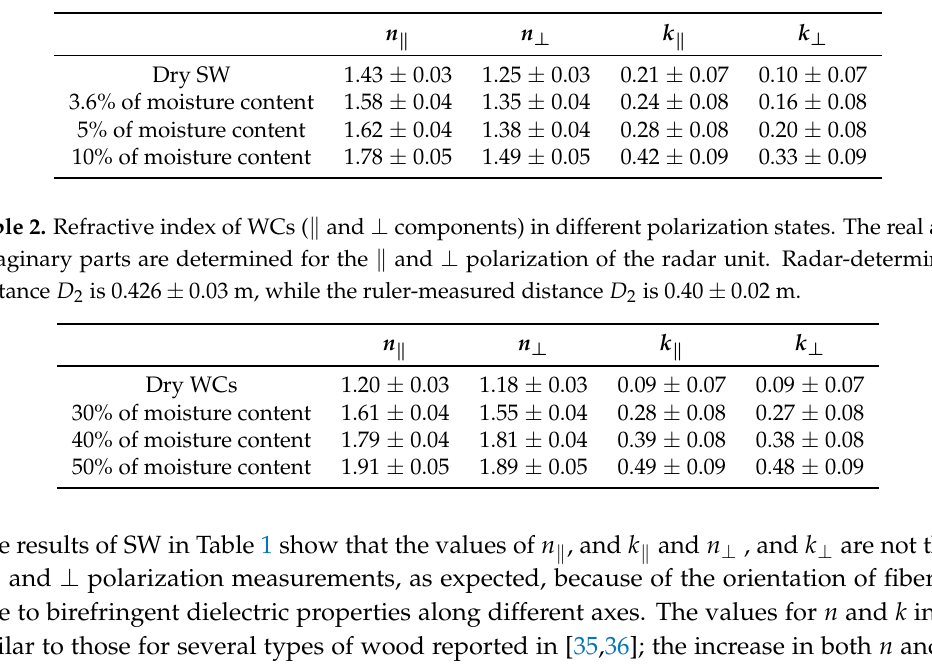
Table 1. Refractive index of SW ( (cid:107) and ⊥ components) in various polarization states. The real and imaginary parts are determined for the (cid:107) and ⊥ polarization of the radar unit. In (cid:107) polarization, the EM wave is parallel to fiber orientation in wood, and so on. Radar-determined distance D 2 is 0.327 ± 0.03 m, while the ruler-measured distance D 2 is 0.30 ± 0.02 m.